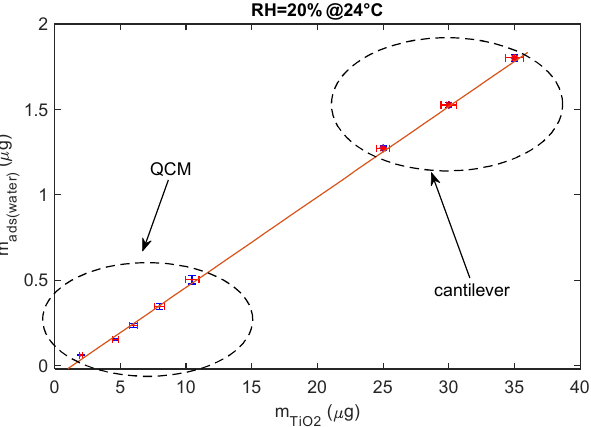
Figure 13. Relationship between deposited TiO 2 nanoparticle mass composing the sensing film and the mass of the adsorbed water (steady state) for RH = 20% at 24 °C.